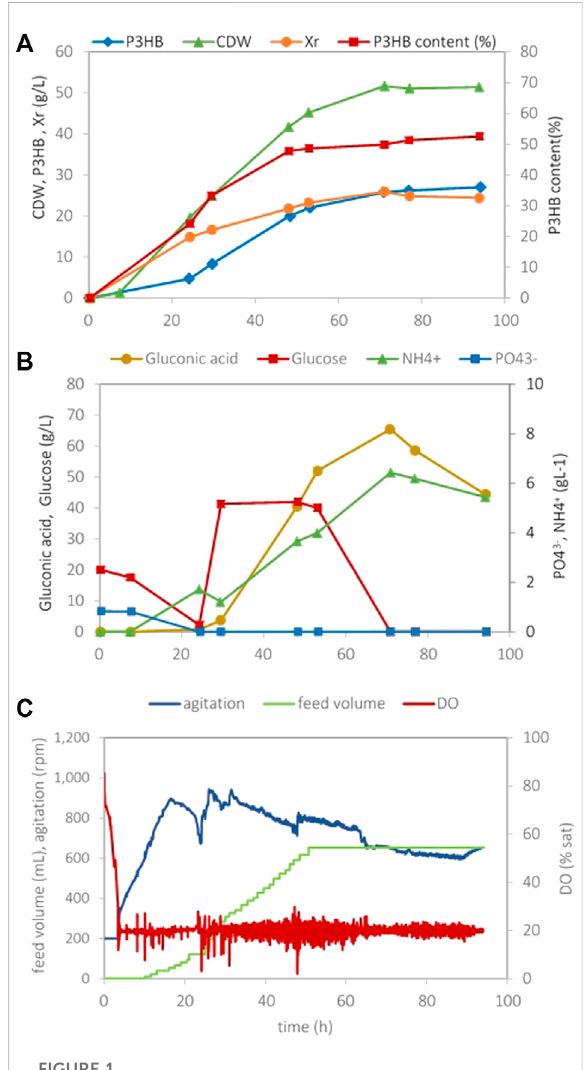
FIGURE 1 Data obtained in H. boliviensis fed-batch cultivation with mineral medium supplemented with 25 g/L of glucose, 1.5 g/L K 2 HPO 4 , and 7.0 g/L NH 4 Cl at pH 7.5 and 20% of DO. A solution containing 600 g/L of glucose (0.5 L) was used as feed. (A) Cell dry weight, P3HB concentration, the residual cell concentration (Xr), and the P3HB cell content during the cultivation, (B) glucose, gluconic acid, phosphate, and ammonia concentrations, and (C) data acquired automatically during the